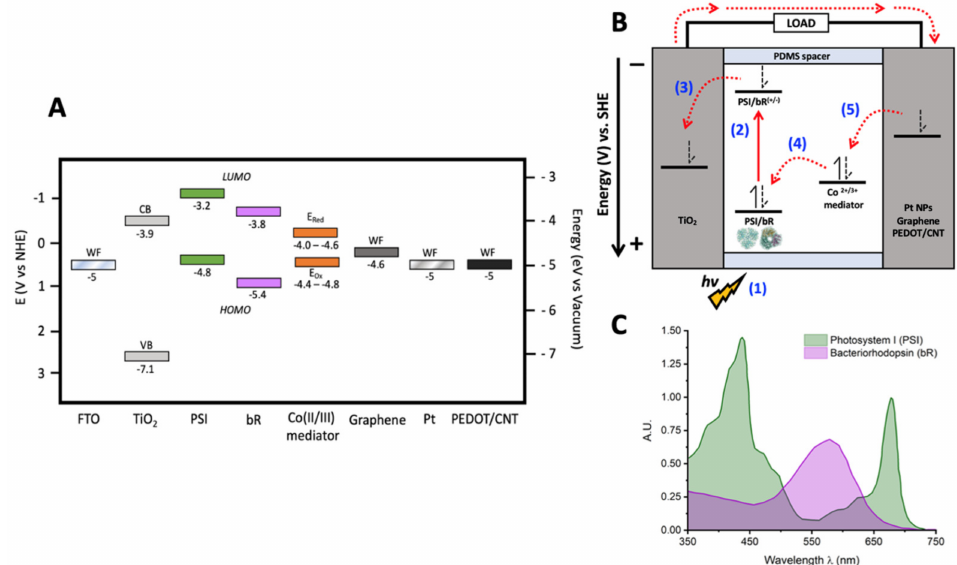
Figure 2. Schematics of PSI or bR sensitized BSSCs. ( A ) Energy levels diagram of all device com- ponents used in this study. Ranges for the values of the Co (II/III) mediator come from the data reported later in this study. Other values and conversions used come from references [45–51]. WF, work function; CB, conduction band; VB, valence band; LUMO, lowest unoccupied molecular orbital; HOMO, highest occupied molecular orbital. ( B ) Fundamental processes and constituent components of a bio-sensitized solar cell (BSSC). ( C ) UV-vis absorbance spectra of PSI and